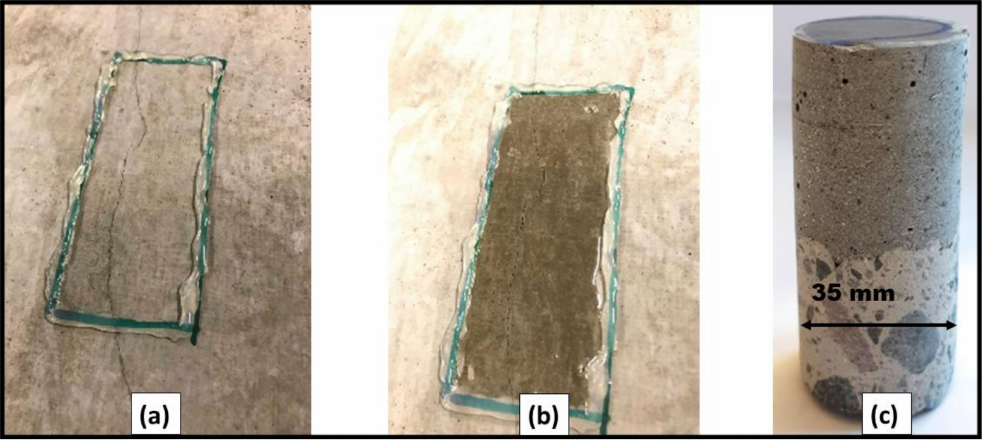
Figure 5. ( a ) Before placing epoxy resin, ( b ) after 24 h set of epoxy resin; ( c ) extracted core going through